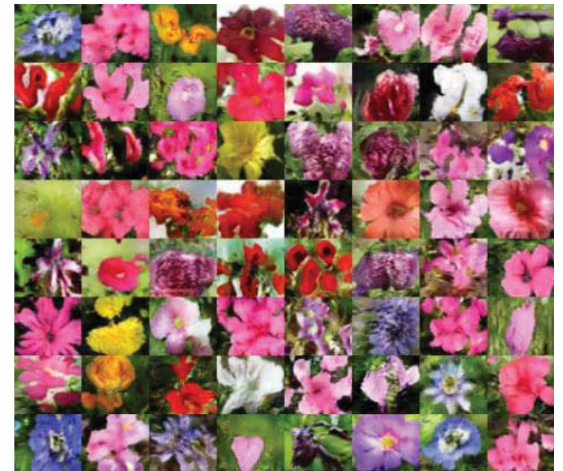
Fig. 11. 8x8 GAN generated image